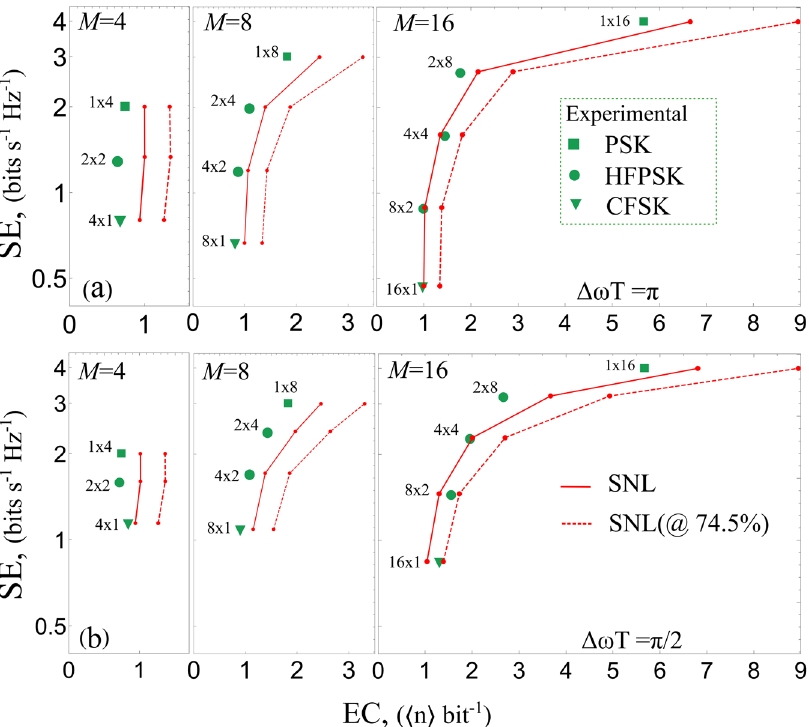
Fig. 4 Spectral ef fi ciency (SE) vs. experimentally measured energy consumption (EC) at SER = 15%. Green- fi lled triangles, circles and squares represent experimental results for CFSK, HFPSK and PSK, respectively. Red dots connected with solid and dashed guide lines represent the absolute SNL and the SNLs adjusted for system ef fi ciency of 74.5%, respectively. Measurements are performed for two different detunings ( a ) Δ ω T = π and ( b ) Δ ω T = π /2. The experimental error bars are smaller than data